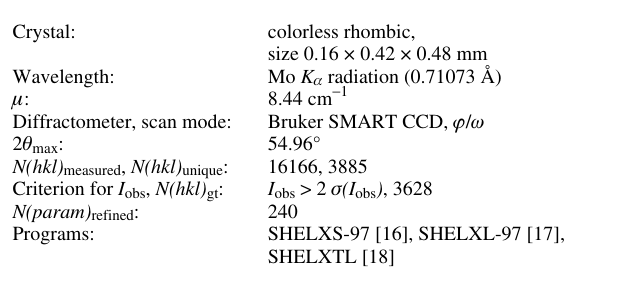
Table 1. Data collection and handling.